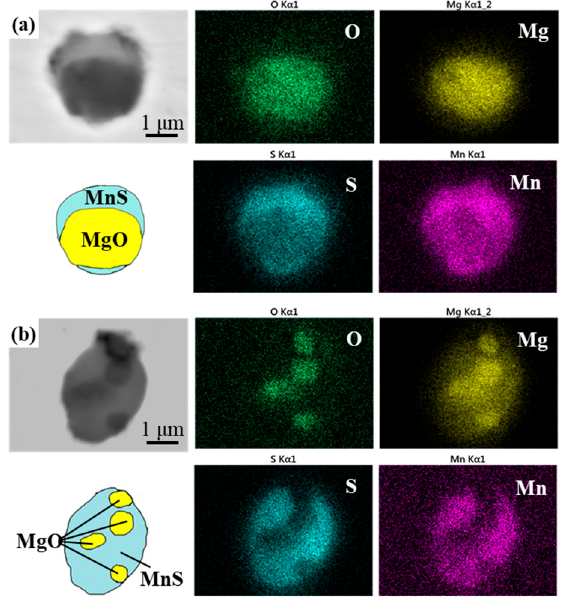
Figure 3. Morphologies and compositions of typical MgO-MnS inclusions. ( a ) 3Mg1Al; ( b ) 3Mg20Al.